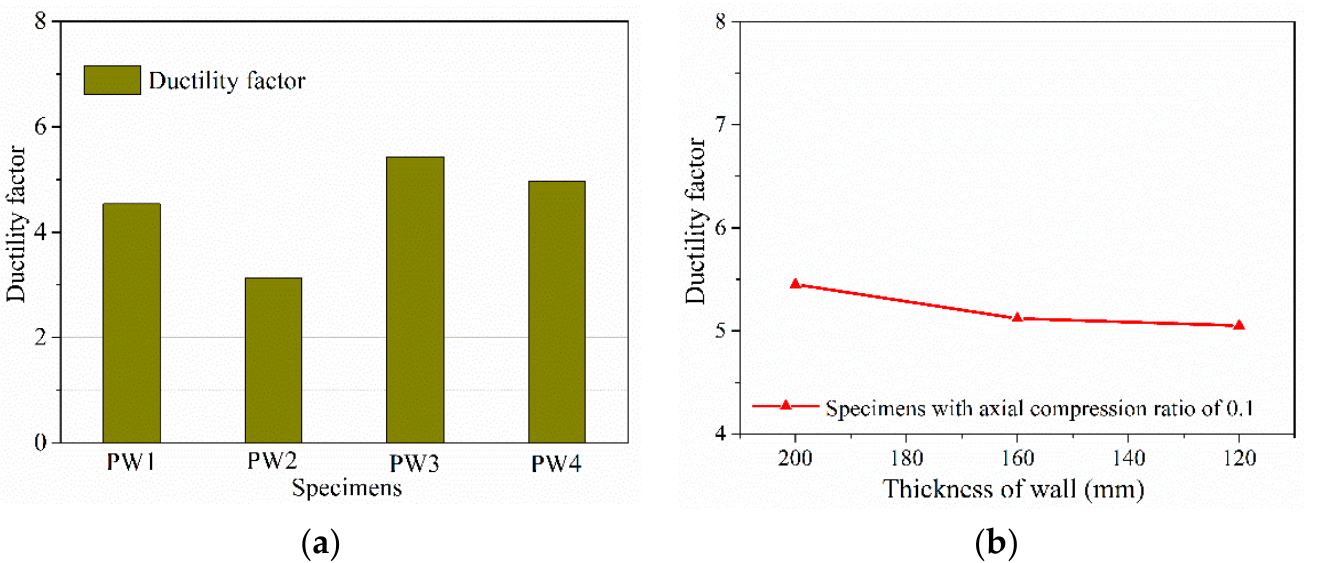
Figure 13. Variable curves of ductility factor for PW1–PW6: ( a ) ductility factor of PW1–PW4 and ( b ) relationship curves between the ductility factor and the concrete wall thickness.